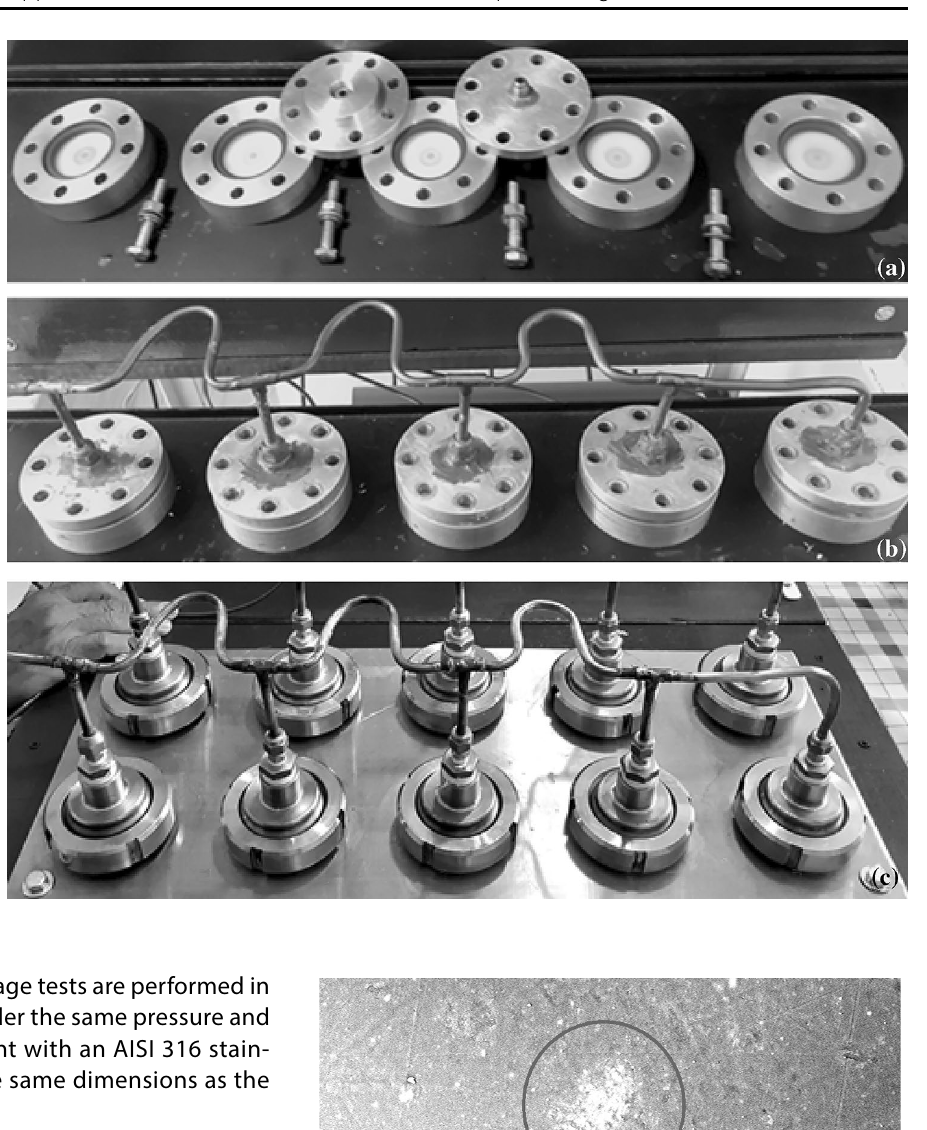
Fig. 2 Permeation chamber in naval aluminium in top view ( a ), sample with O-ring ( b ) of the previous equipment, and top view of the permea- tion chamber of the current permeameter ( c )